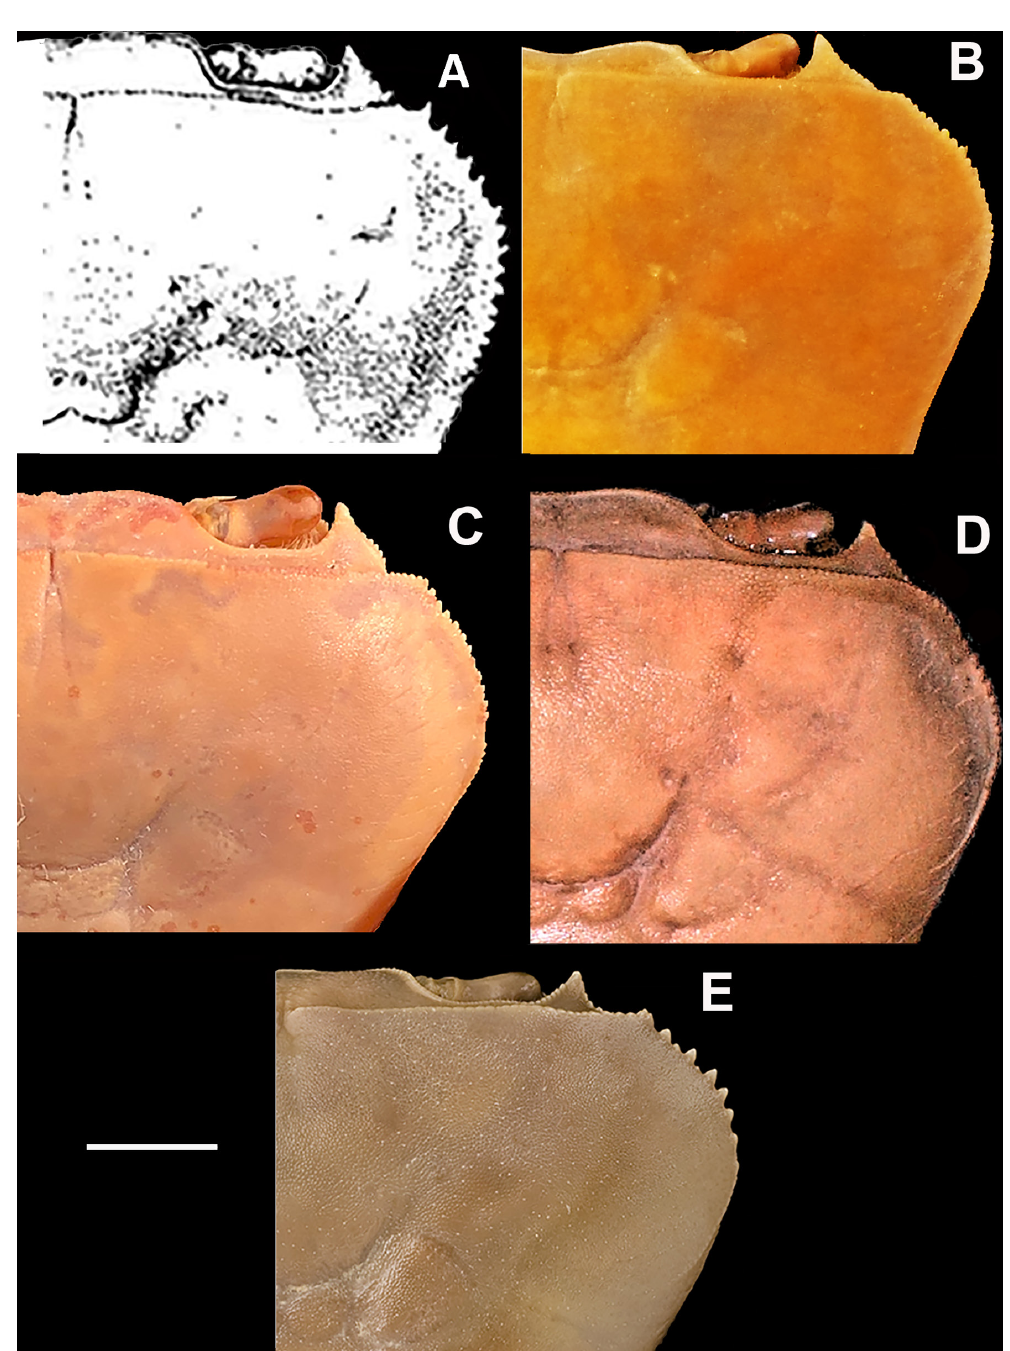
Fig. 4. Dorsal view of the right side of the carapace. A . Potamonautes lirrangensis s. str., holotype, adult, ♀, CW 53.6 mm, from Liranga, République du Congo (MNHN B-3826) (Capart 1954: fig. 28). B . P. kisangani sp. nov., holotype, adult, ♂, CW 60.5 mm, from Kisangani, Democratic Republic of the Congo (USNM 98944). C . P. amosae sp. nov., holotype, adult, ♂, CW 46.5 mm, from Lake Kivu, D.R. Congo (NHMUK 2018.306). D . P. amosae sp. nov., adult, ♂, CW 39.5 mm, from Kigoma District near Lake Tanganyika, Tanzania (NMU TRW 1971.05). E . P. orbitospinus (Cunnington, 1907), lectotype, adult, ♂, CW 56.9 mm, from Nkhata Bay, Lake Malawi, Malawi (NHMUK 1908.1.31.27). Scale bar: A = 8.7 mm; B = 7.9 mm; C = 6.8 mm; D = 5.7 mm; E = 7.9 mm. Photograph E by Phillip Crabb,